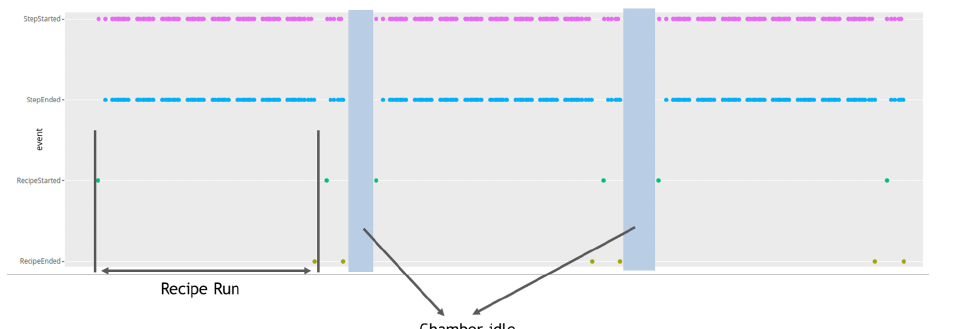
Figure 11. WaferMap .